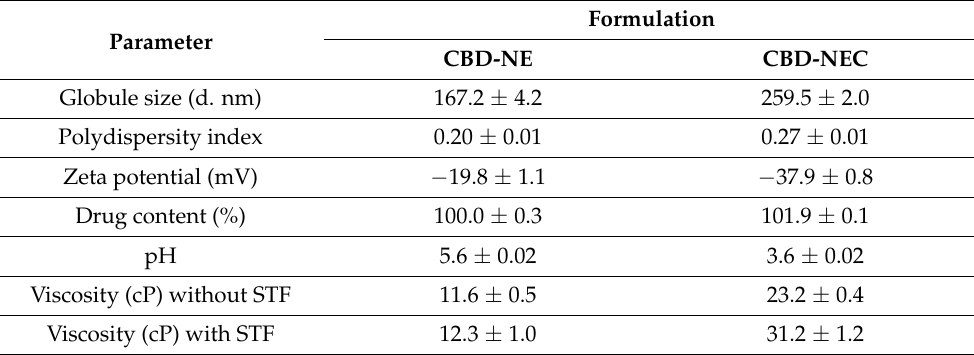
Table 2. Globule size, PDI, zeta potential, drug content, pH, and viscosity of the CBD-NE and CBD-NEC formulations (mean ± SD, n =